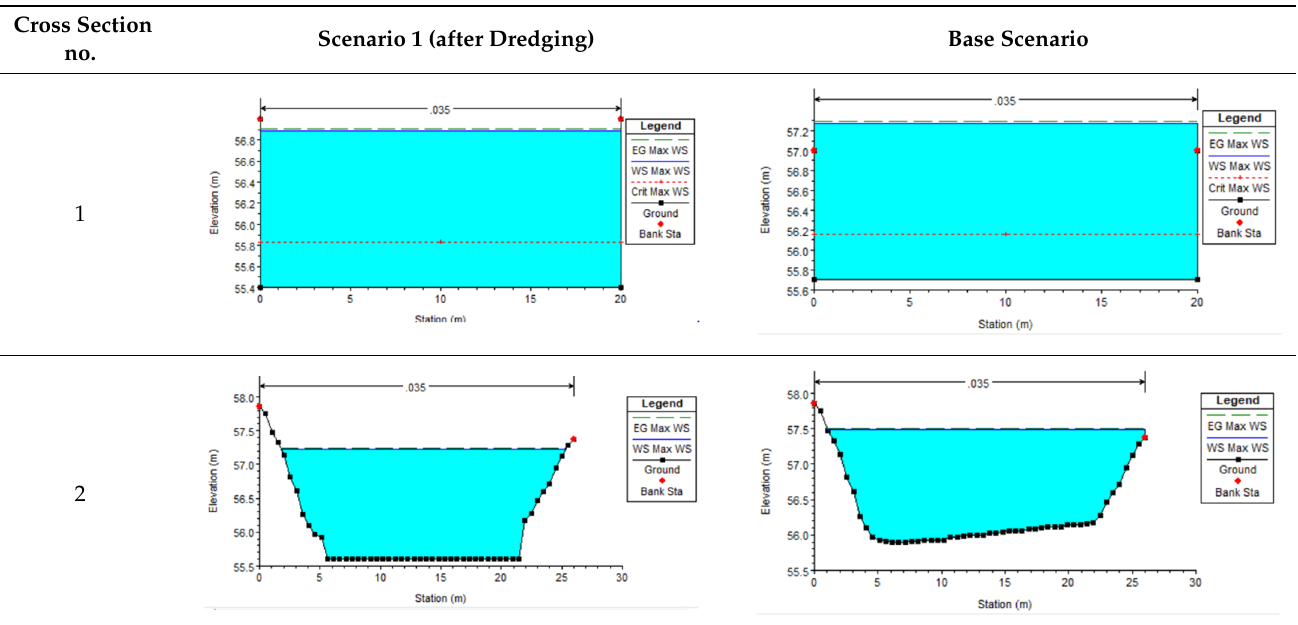
Table 6. Comparison of water stage between the base scenario and after-dredging scenario for different cross sections. The locations of the cross sections can be found in Figure